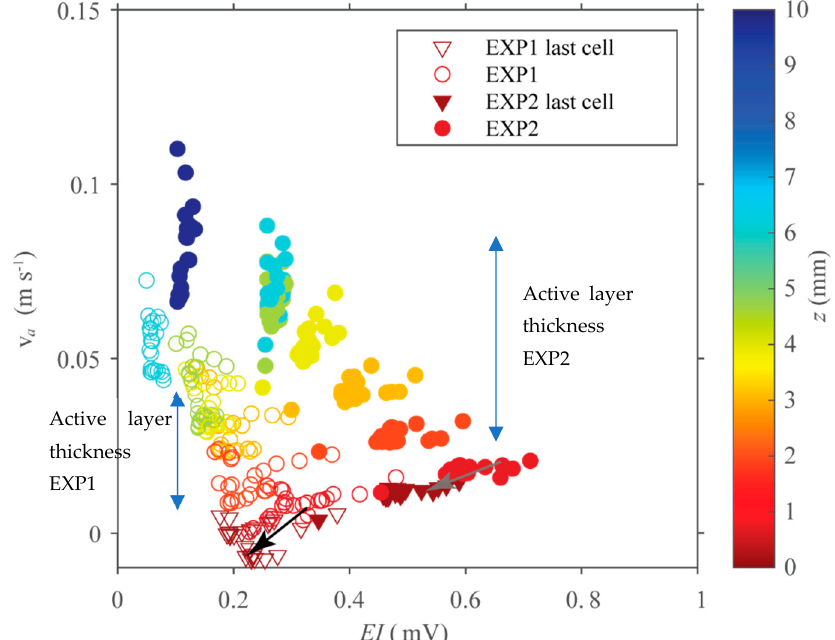
Figure 9. ADVP echo intensity throughout the cells close to the mobile sediment bed, z is the distance to the immobile sediment bed (e.g., z = 0). The black / gray arrows show the decrease of the amplitudes due to the surface irregularity and signal attenuation, passing from circle symbols to triangle